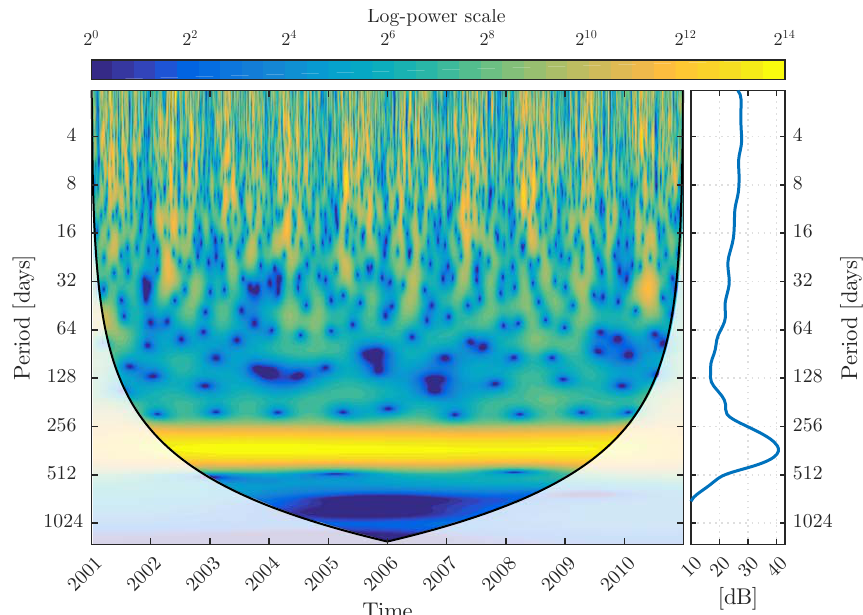
Figure 2. The wavelet power spectrum (left panel) of the ten year time-series of SSI under study, spanning 2001 through 2010. Pixel colour encodes power (logarithmic scale colour bar on top) at each time (abscissa) and each scale (ordinate). Time markers on the abscissa denote the start of the corresponding year. The white-out area indicates the regions where edge effects become significant. The global wavelet spectrum in the right panel is the time-integrated version, i.e. line-by-line sum, of the wavelet spectrum and indicates the amount of power at each scale, expressed in